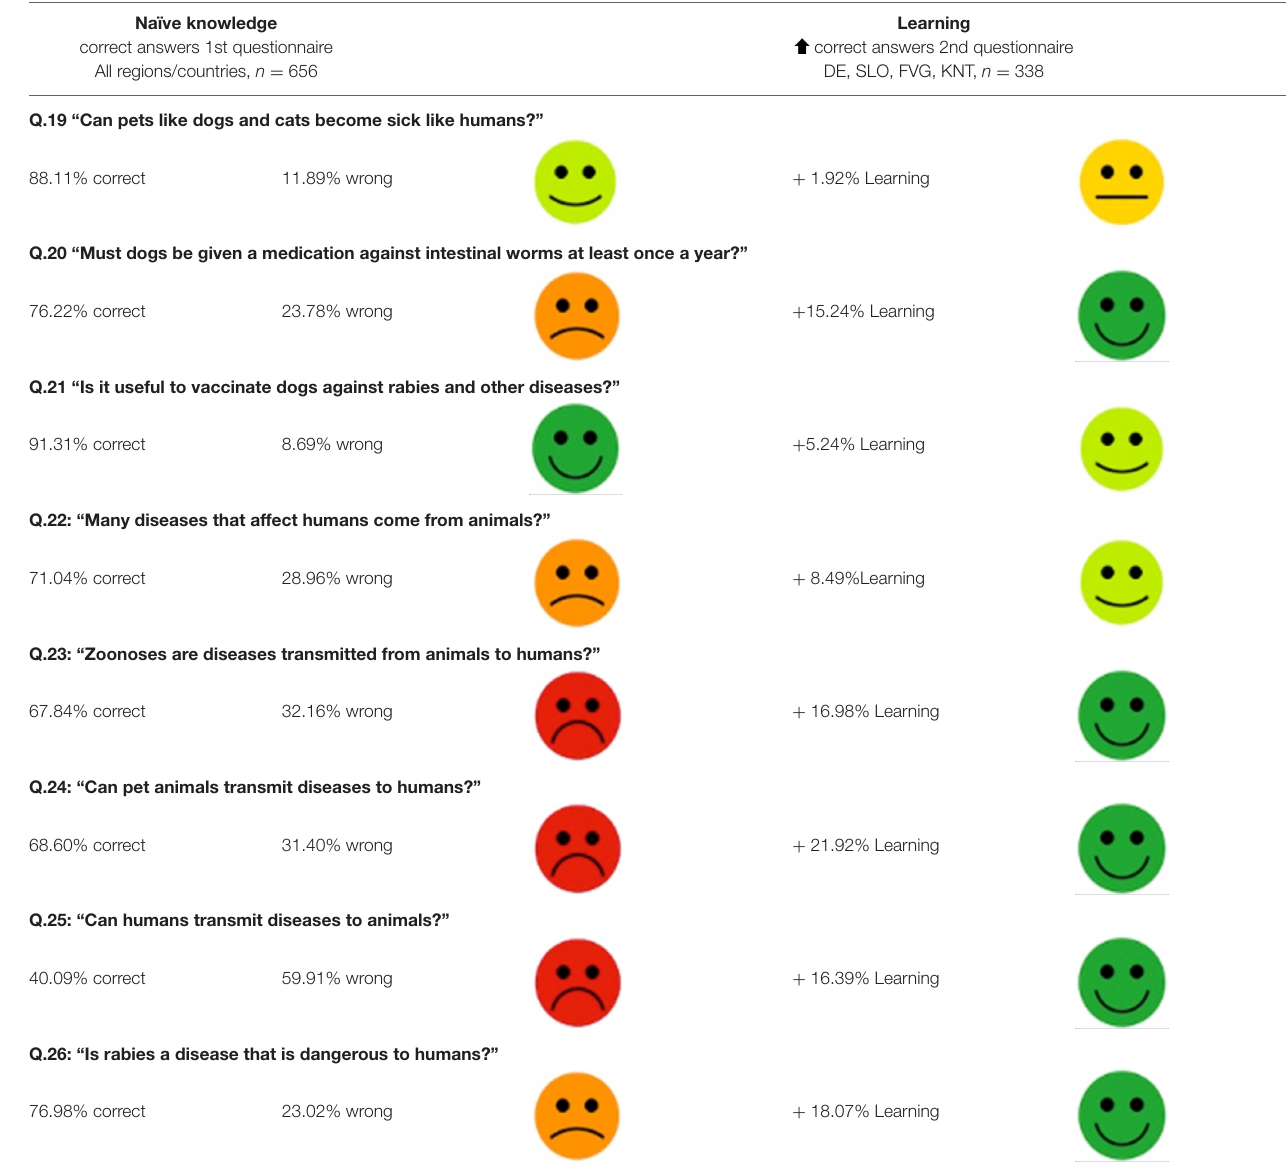
TABLE 2 | Naïve knowledge–correct answers 1st questionnarie before any lecture–all regions or countries – n = 656; Learning–% increasing correct answers 2nd questionnaire after two lectures, DE, Germany; SLO, Slovenia; FVG, Friuli Venezia Giulia; KNT, Carinthia, n = 338: Emoticon scale from 5 good (dark green) to 1 very bad (dark